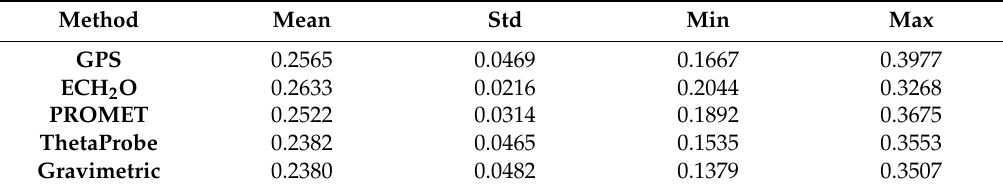
Table 3. Statistical overview of the soil moisture retrieval from GPS, ECH 2 O, ThetaProbe and gravimetric samples as well as the modelled soil moisture with PROMET at the DWD test site in Munich during the measurement period 1 January 2014–10 June 2015.